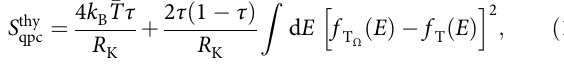
(same color). For example, the brown dashed line in the top part of Fig. 3a (closest to J el